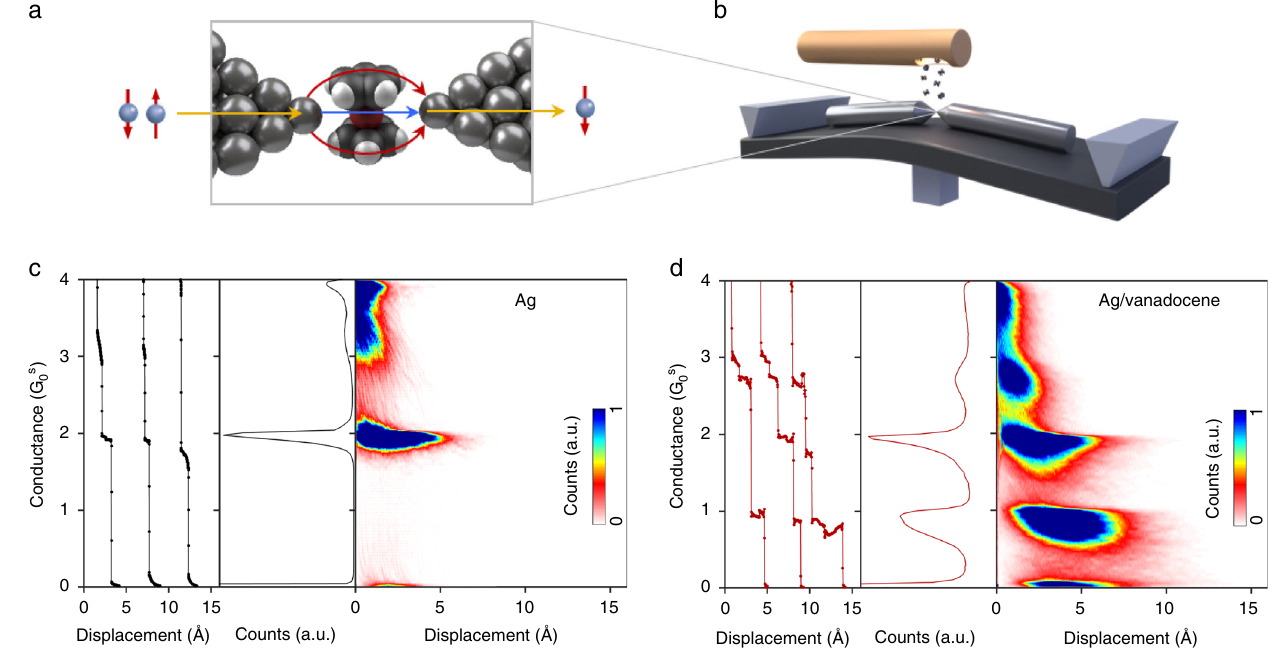
Fig. 1 Measured conductance of bare silver atomic-scale junctions and Ag/vanadocene molecular junctions. a Schematic representation of spin- fi ltering by interfering current pathways in a Ag/vanadocene single-molecule junction. b Schematics of the break-junction setup. c Characterization of bare silver atomic junctions. Left panel: examples for conductance versus inter-electrode displacement traces recorded at a bias voltage of 100mV, with traces shifted in the displacement axis for clarity; Middle panel: conductance histogram constructed from 5,000 conductance traces; Right panel: conductance – displacement density plot based on the same conductance traces. d Similar characterization for Ag/vanadocene molecular junctions, with histograms based on the same number of traces. Zero displacement is determined for each conductance trace by the fi rst displacement point with a conductance value below 4 G s measurement circuit can be found in Supplementary Note